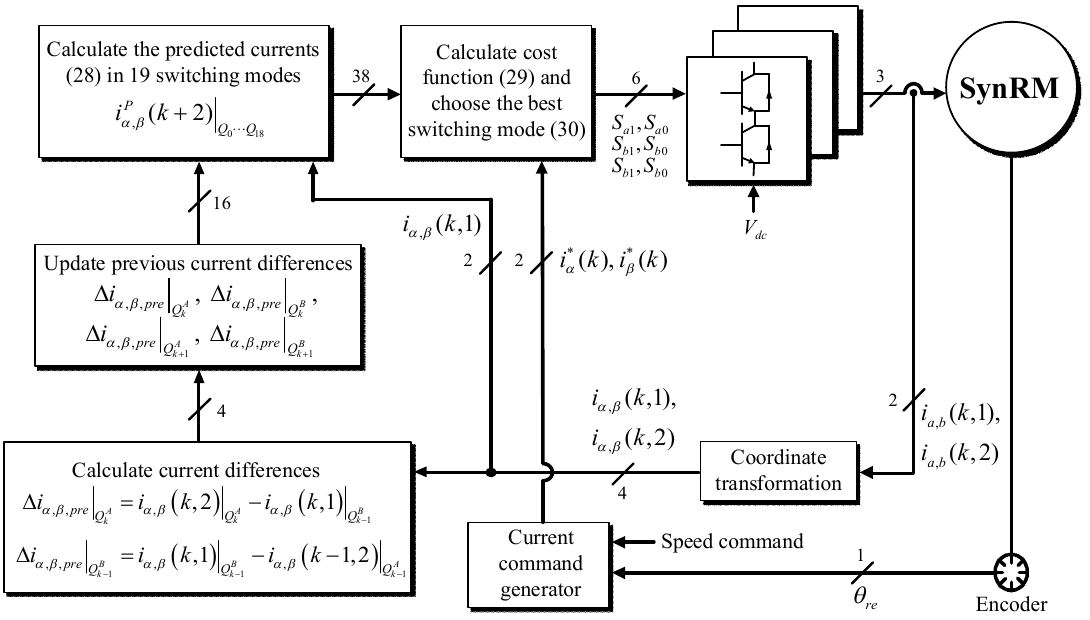
Figure 5. System block diagram of the proposed DVV-MFPCC.